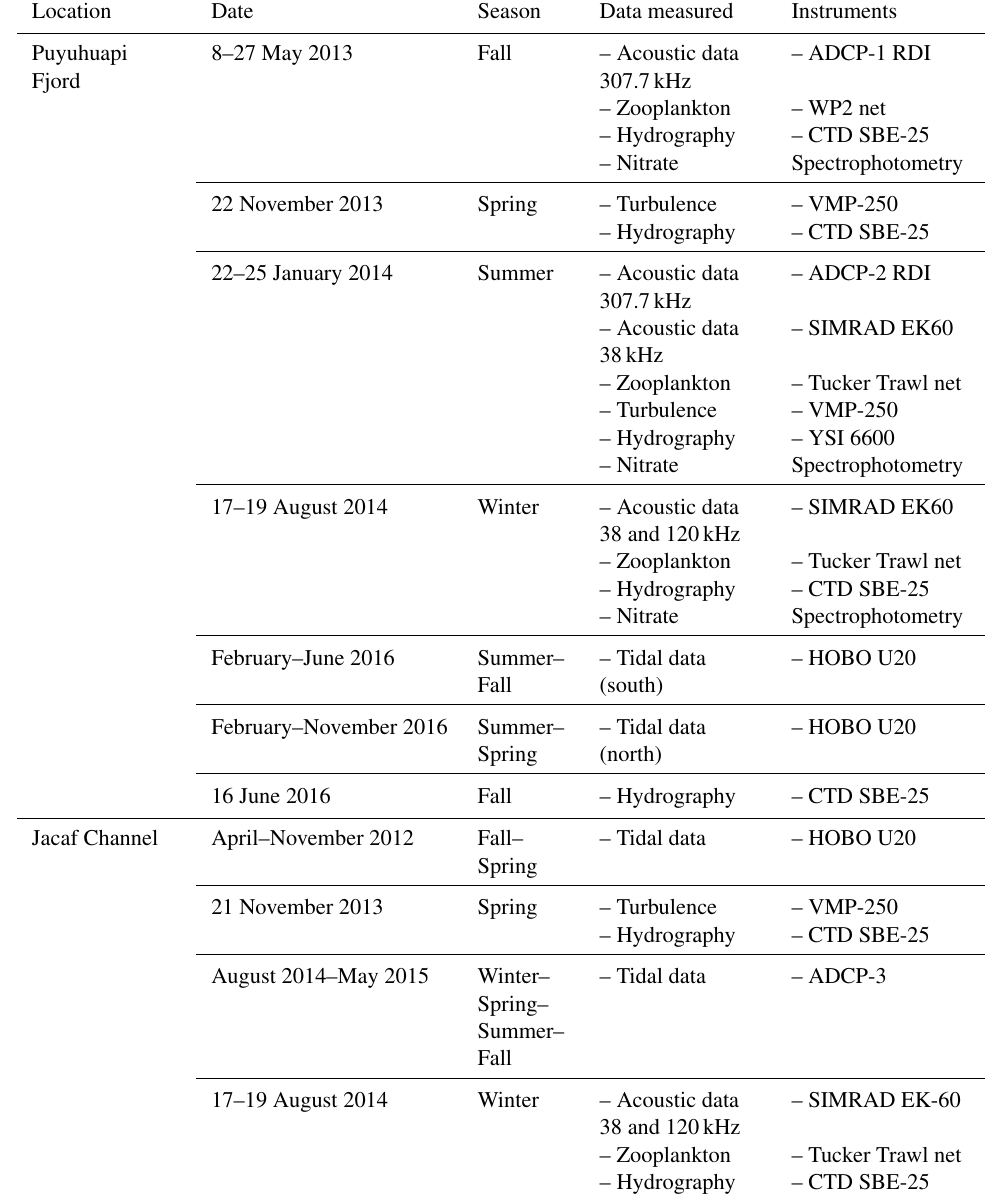
Table 1. Data set collected during oceanographic campaigns in Puyuhuapi Fjord and Jacaf Channel.